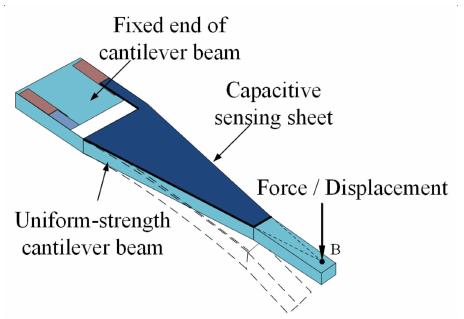
Figure 3. Deformation of the tactile sensor induced by normal force/displacement at the free end of the beam.